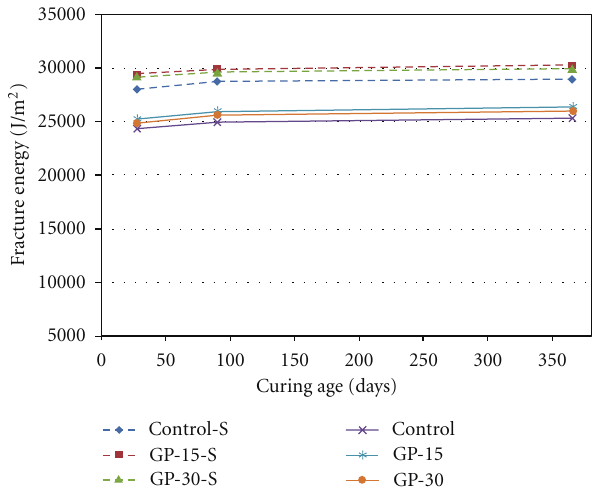
Figure 6: E ff ect of r-FA on flexural strength of UHPFRC with and without steam curing.